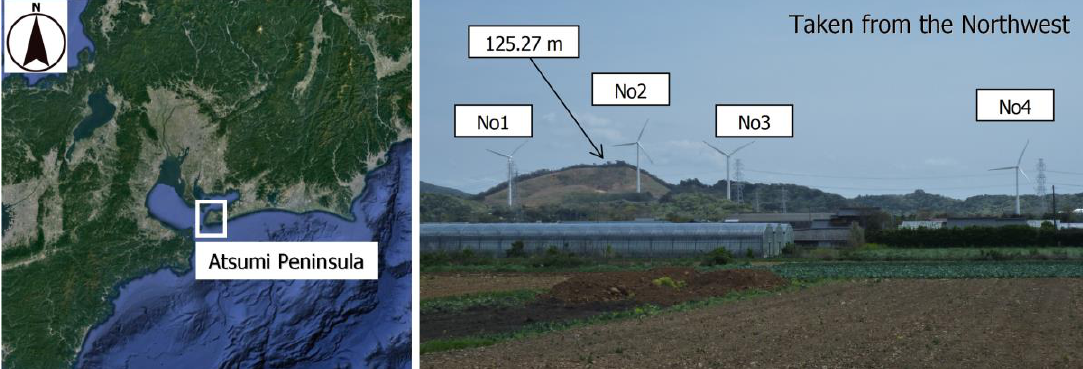
Figure 1. Four wind turbines at Atsumi Wind Farm, Aichi Prefecture, Japan.